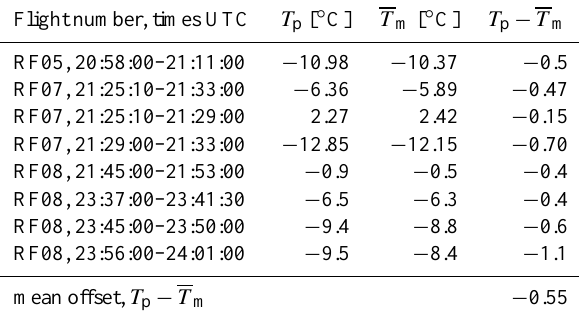
Table 2. Comparisons of predicted and measured temperatures from climbs and descents of the C-130. The segments are from flights RF05, RF06 and RF08 flown respectively on 7, 15 and 17 Novem- ber 2011. T p is the predicted temperature and T m is the weighted mean of the measured values of temperature, as defined in the